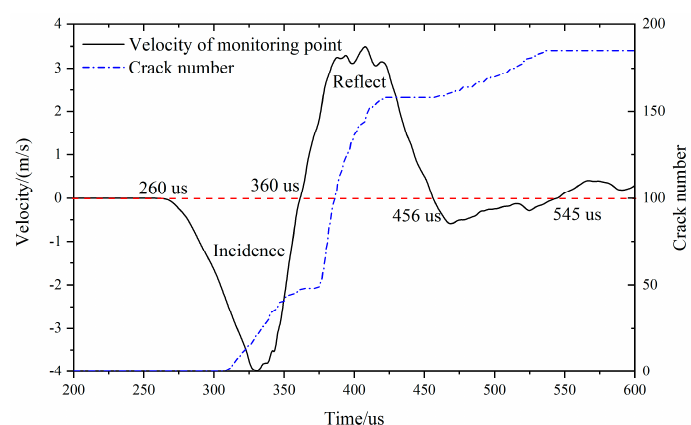
Figure 11. Layout of monitoring point and measuring circles.